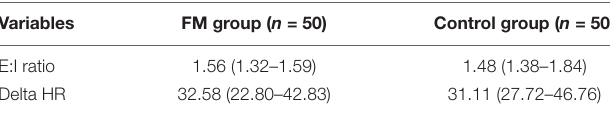
TABLE 5 | Comparison of tonic electro-dermal amplitude (microsiemens) during rest, cold pressor test, and deep breathing test between two study groups, fibromyalgia patients and control.